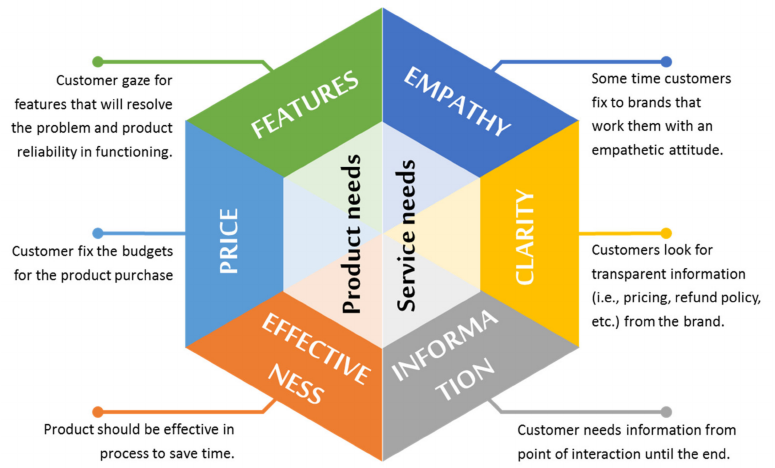
Figure 1. Type of CNs and its two verticals such as product needs and service